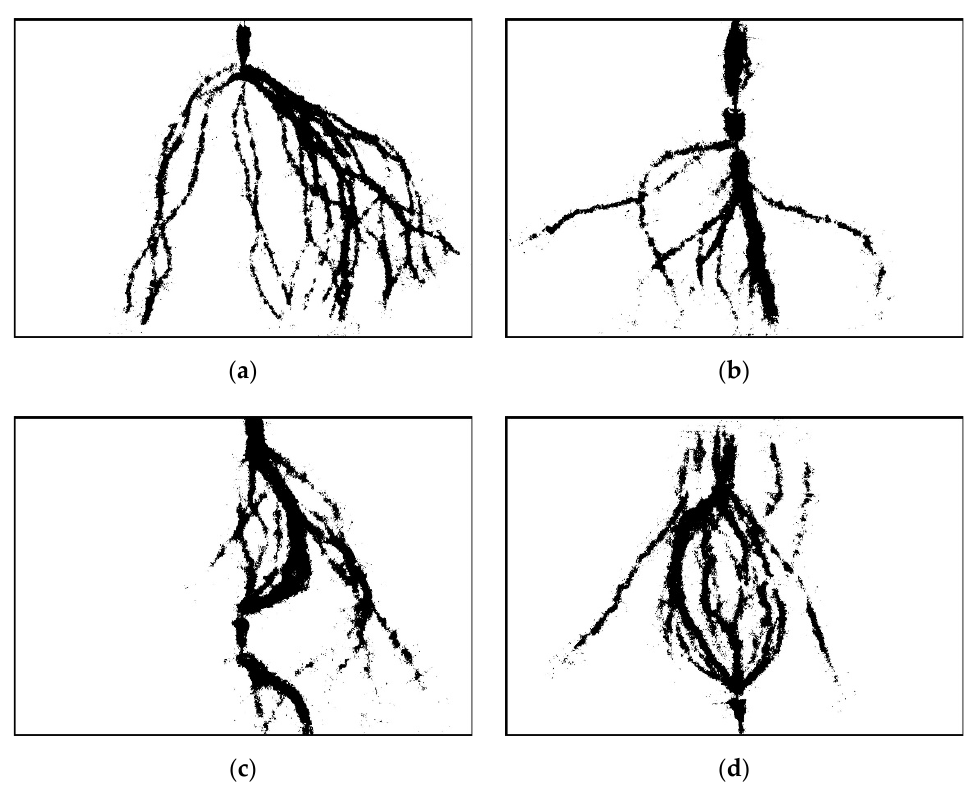
Figure 11. Conversion of tracking image from RGB to gray ‐ level by compensable algorithm. In ( a ), the particle is located at 19 mm. In ( b ), the particle is located at 71 mm. In ( c ), the particle is located at 123 mm. And in ( d ), the particle is located at 175 mm from HV electrode.